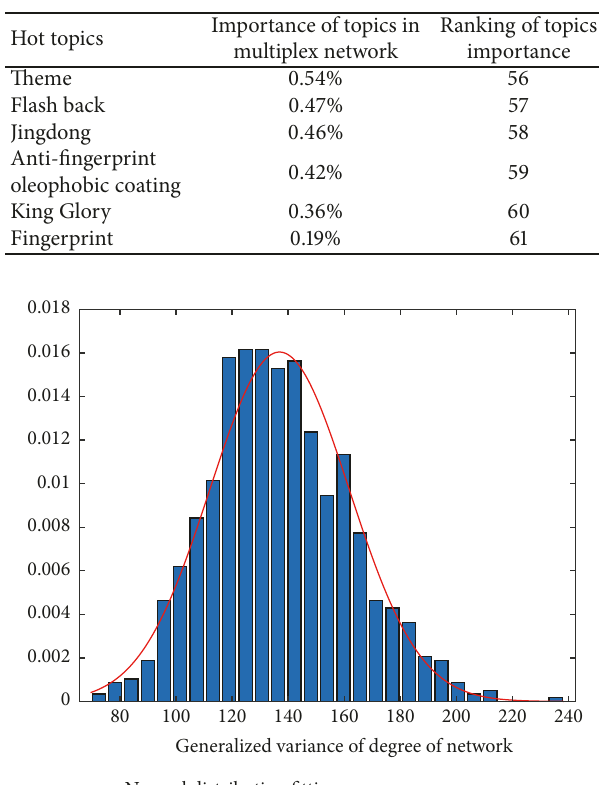
Figure 9: Generalized variance of degree of network of null model of